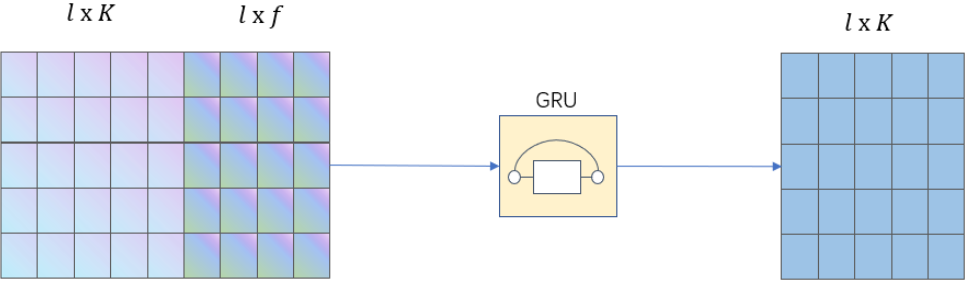
Figure 4. Feature fusion